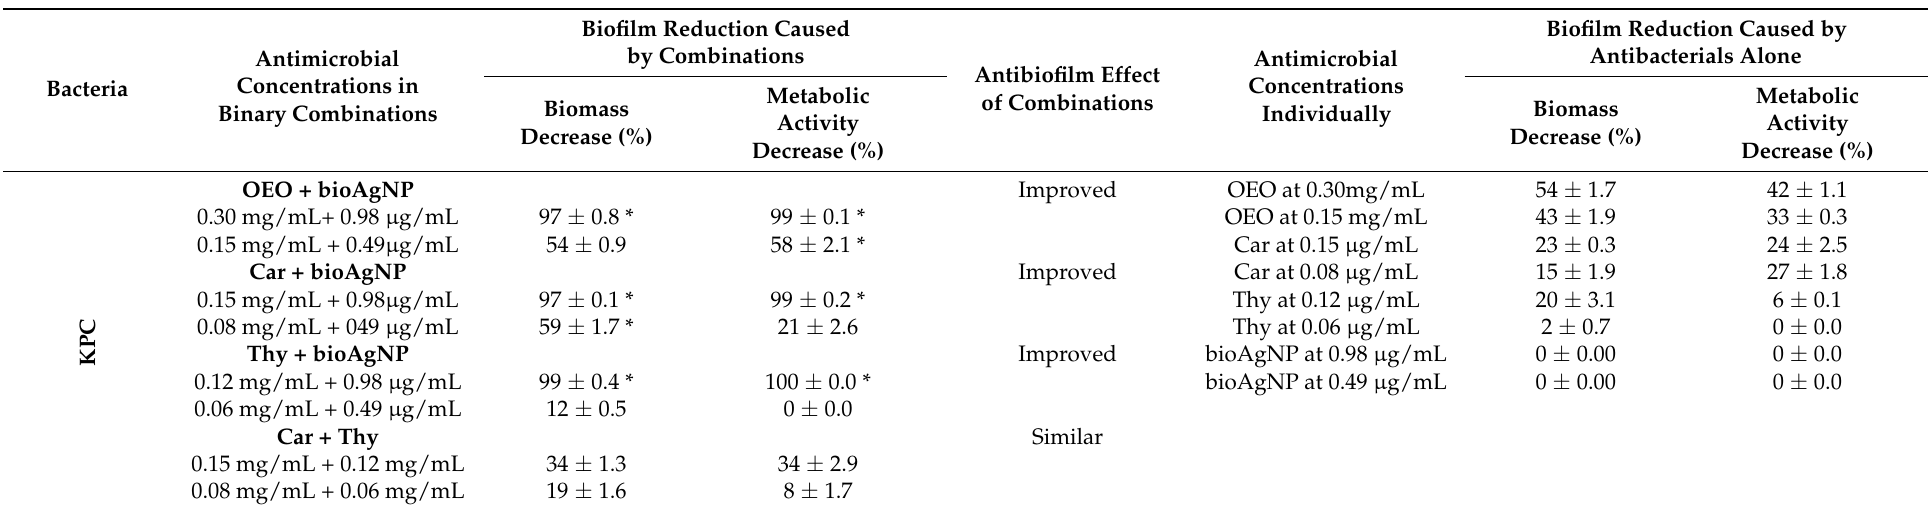
Table 4. Antibiofilm effect, shown in terms of biomass and metabolic activity reduction, of oregano derivatives combined with biological silver nanoparticles (bioAgNP) compared to both antimicrobials individually against KPC-producing Klebsiella pneumoniae (KPC) biofilms growth in microtiter plates, which were evaluated at an early stage of biofilm